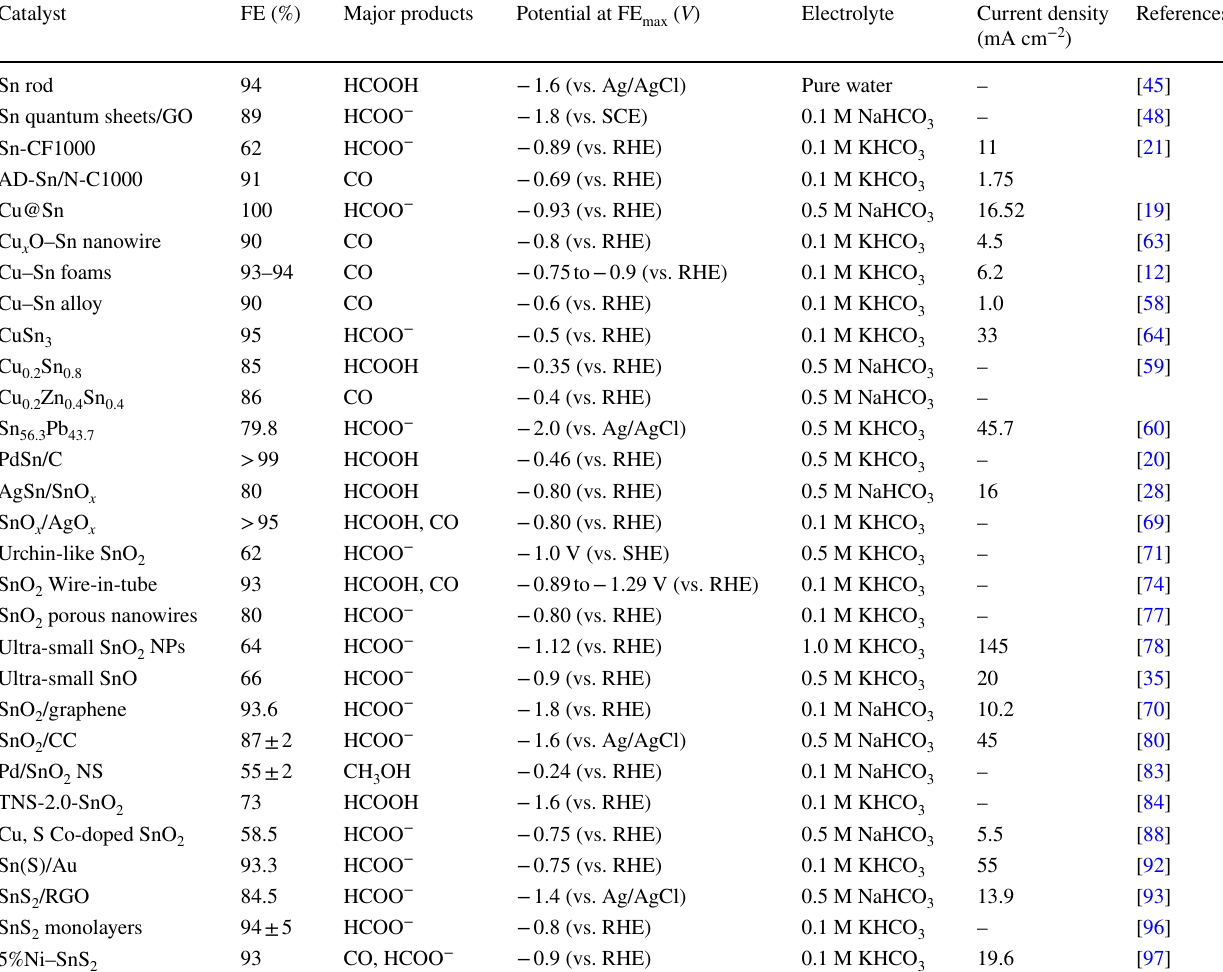
Table 2 Performance of Sn‑based catalysts in CO 2 electroreduction